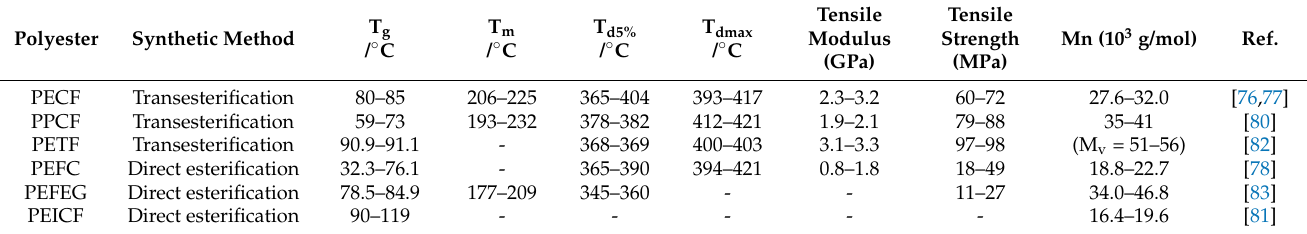
Table 3. Thermal and mechanical properties of furan co-polyesters based on